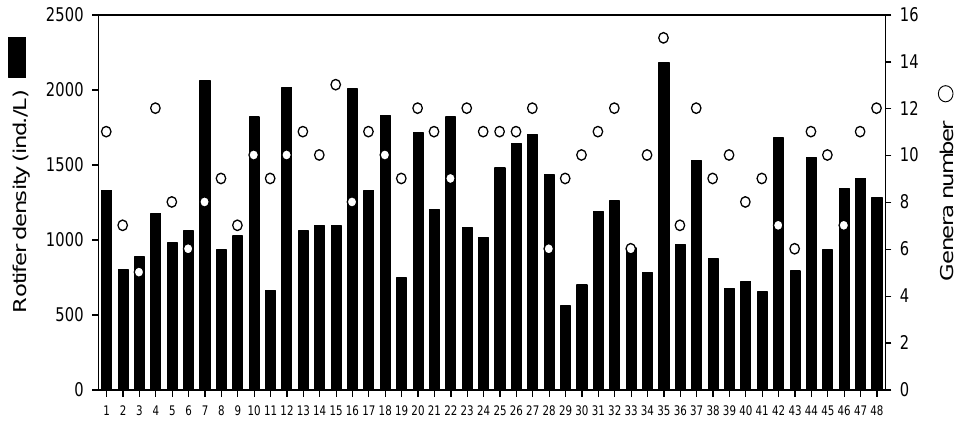
Figure 2. Density and genera number of rotifers in 48 artificially created riverine wetlands.